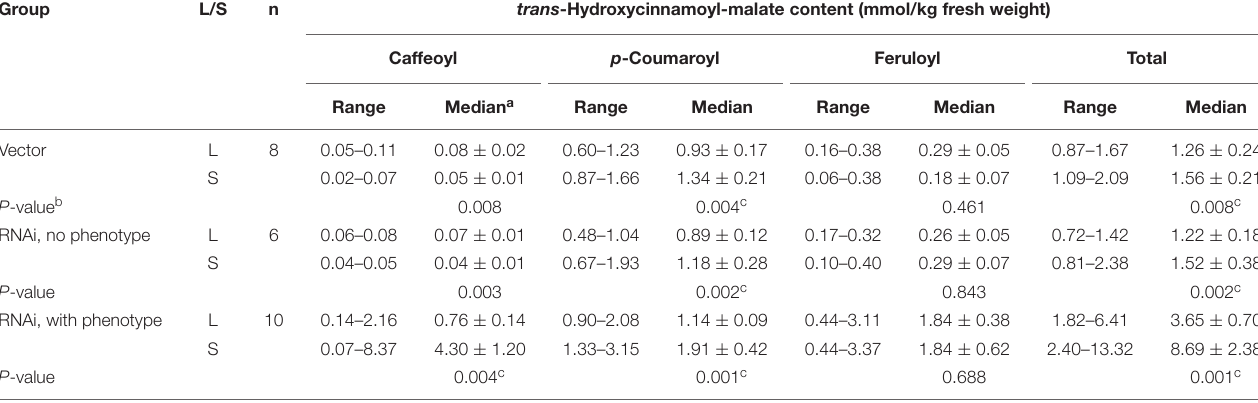
TABLE 5 | Accumulation of hydroxycinnamoyl esters in leaves (L) and stems (S) of plants transformed with HMT and CCOMT RNAi (without and with the caffeoyl-malate accumulation phenotype) or vector control. Group L/S